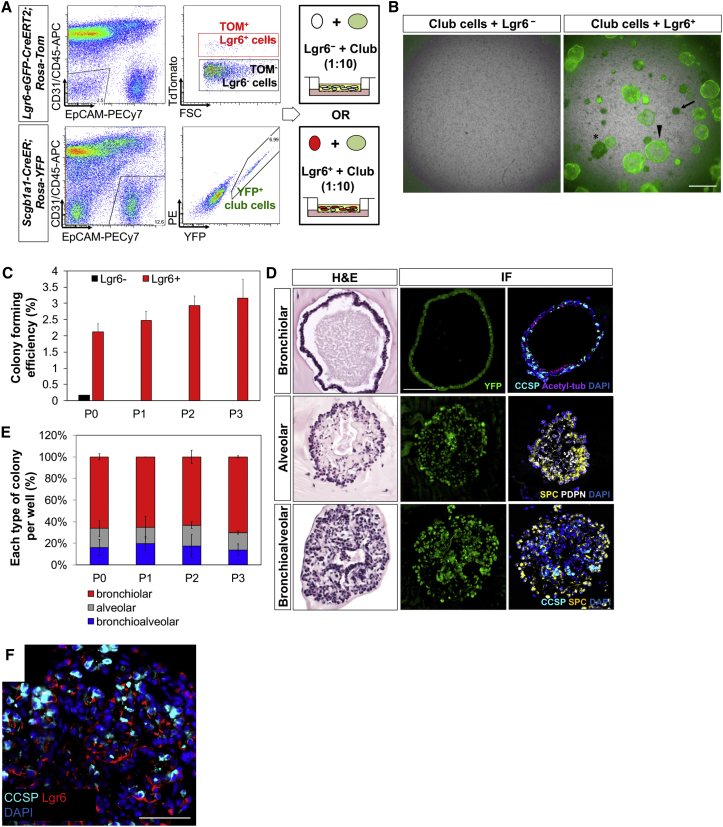
Multi-lineage Differentiation of Lineage-Labeled Scgb1a1+ Cells in Organoid Co-culture with Lgr6+ Cells(A) Diagram of experimental setup for organoid co-culture of Scgb1a1+ cells with Lgr6− and Lgr6+ cells.(B) Representative merged images of lung organoids derived from lineage-labeled YFP+Scgb1a1+ cells co-cultured with Lgr6− or Lgr6+ cells in 14-day culture. Note heterotypic colony formation from Scgb1a1+ cells. Arrowhead, bronchiolar colony; arrow, alveolar colony; asterisk, bronchioalveolar colony.(C) Colony forming efficiency of Scgb1a1+/Lgr6+ organoids with serial passages. P0, passage 0; P1, passage 1; P2, passage 2; P3, passage 3.(D) Representative images of organoids from Scgb1a1+/Lgr6+ co-cultures; bronchiolar (top), alveolar (middle), and bronchioalveolar (bottom) colonies. H&E (left) and IF (right) for YFP (green), CCSP (cyan), acetylated tubulin (purple), SPC (yellow), PDPN (white), and DAPI (blue) are shown.(E) Quantification of each distinct type of colony from Scgb1a1+/Lgr6+ co-cultures.(F) Representative IF image showing integration of Lgr6+ cells within epithelial organoids in (B): CCSP (cyan); TdTomato (for Lgr6, red); and DAPI (blue). Data presented are the mean of three independent experiments with triplicate wells.Error bars indicate SD (C and E). The scale bars represent 500 μm (A) and 100 μm (D and F). See also Figure S4.